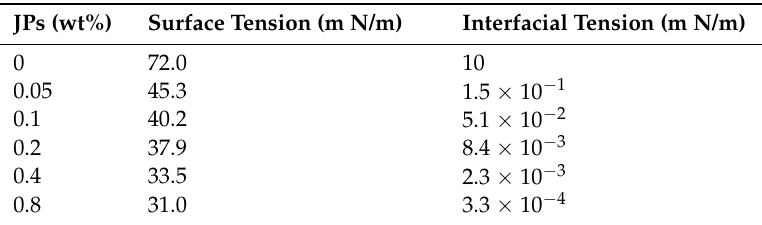
Table 4. measuring of Surface/Interfacial tension.